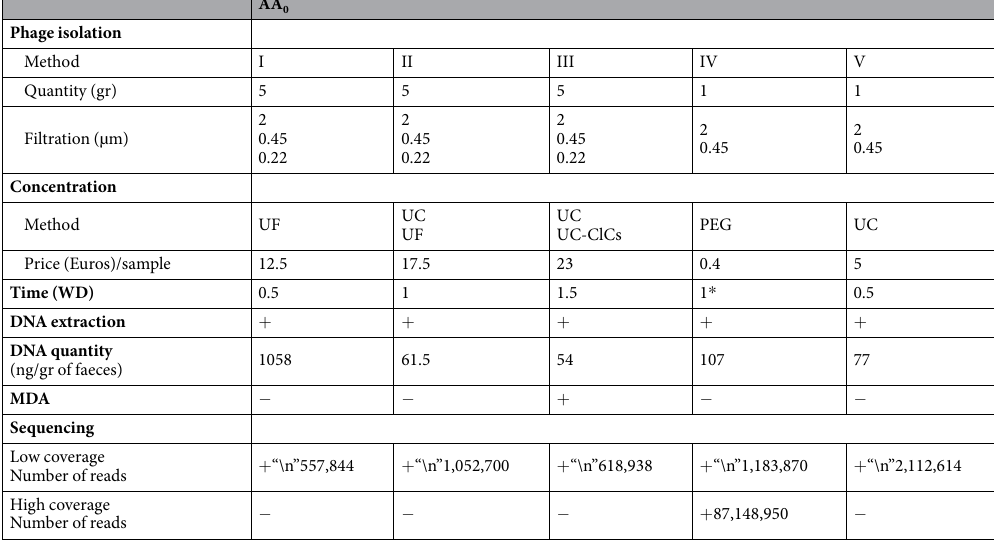
Table 1. Main characteristics of the analyses performed on the AA 0 faecal sample. Abbreviations: UF- Ultrafiltration, UC-Ultracentrifugation; CsCl-Cesium chloride, PEG- Polyethylene glycol, WD-Working day, MDA- Multiple displacement amplification, * Including O/N